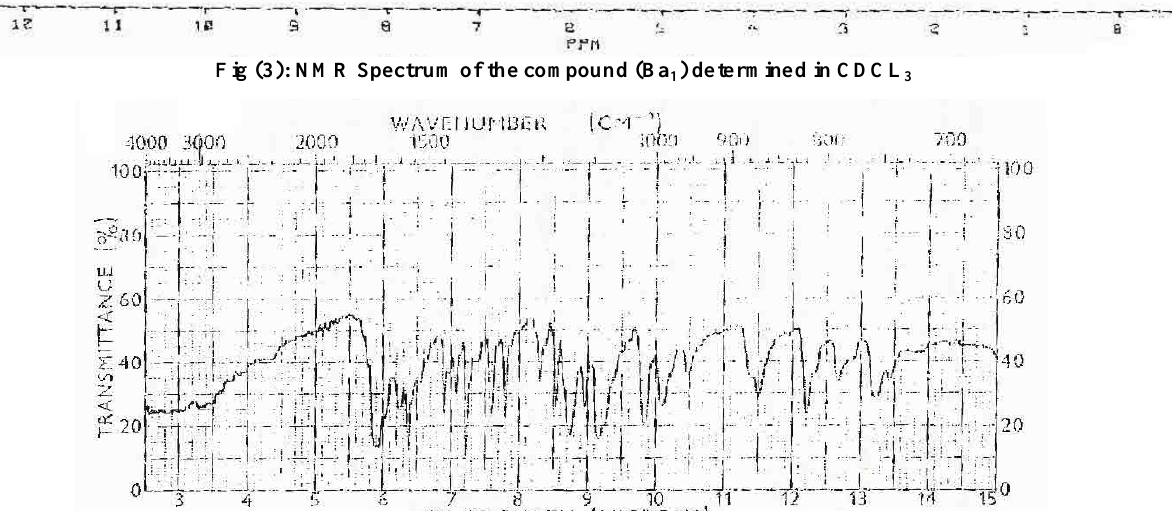
Fig (3): NMR Spectrum of the compound (Ba 1 ) determined in CDCL 3